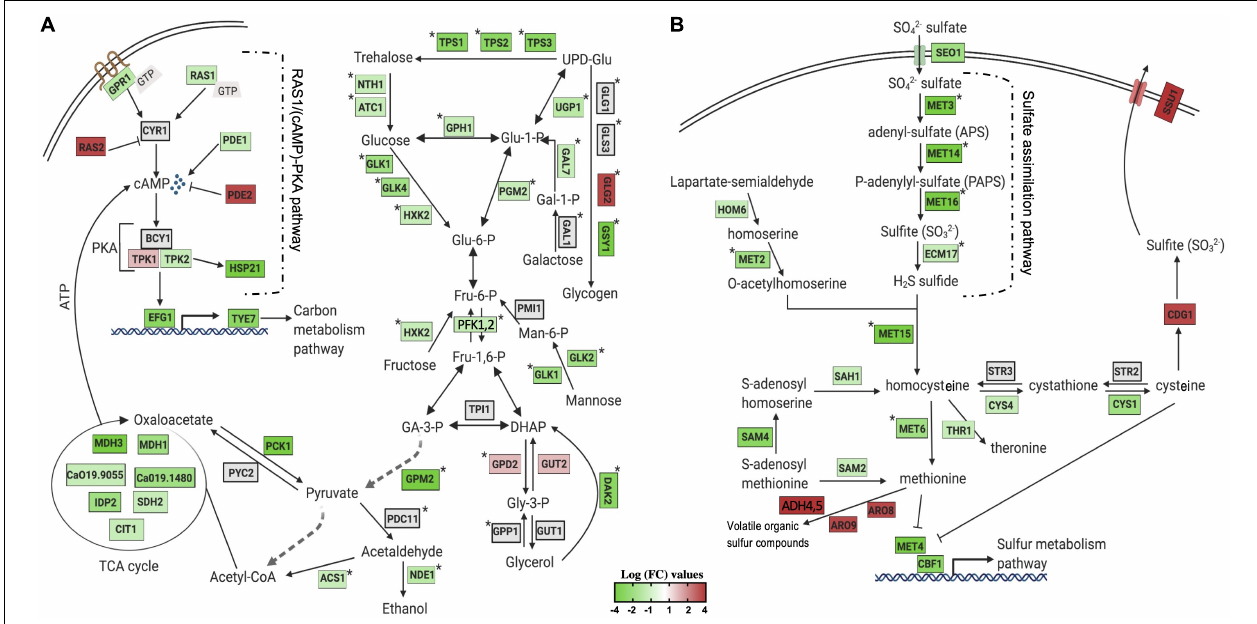
FIGURE 4 | Visualization of the impact of aurone treatment on the central metabolism of significantly enriched KEGG pathways. The changes in gene expression in central carbon and sulfur metabolic pathways in response to SH1009 (A) and SH9051 (B) treatments. Detected genes are colored based on their values of log fold change, green and red colors indicate down- and up-regulated genes, respectively; a gray color indicates undetected genes. Pathway annotations and gene names are customized from different studies on C. albicans or based on their homology in S. cerevisiae and created with BioRender.com. Stars indicate genes that are directly activated by the major transcriptional activators Tye7p for carbon metabolism and Met4p for sulfur